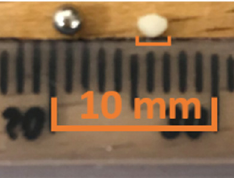
Figure 15. Illustration of the size and shape of the TMM particle. A 2 mm ball bearing is used as a reference.